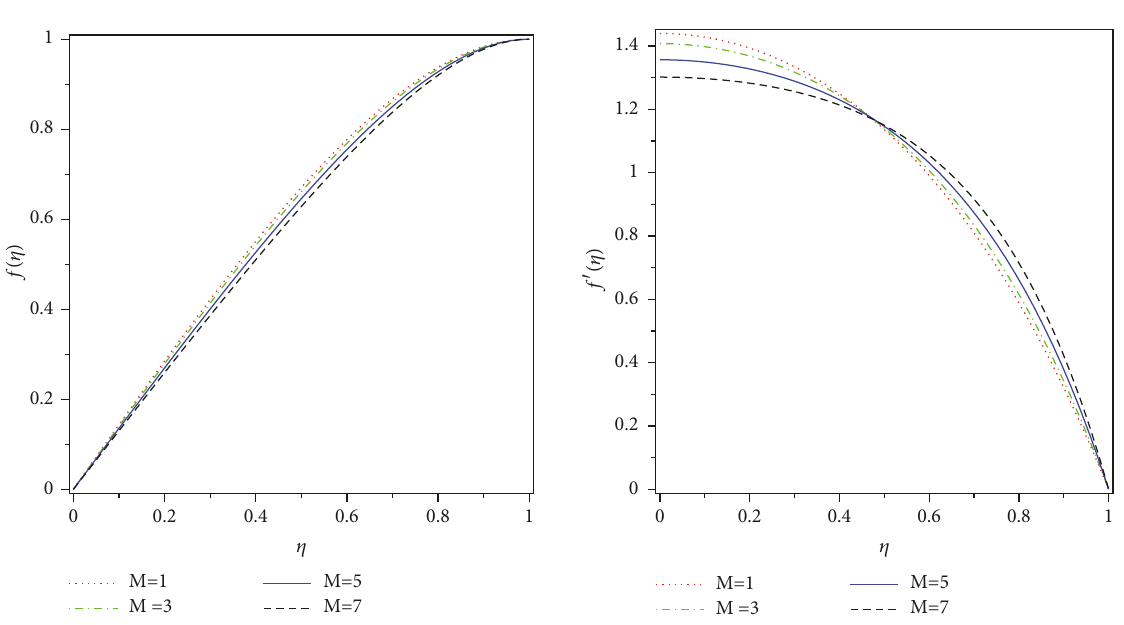
Figure 3: 𝑓(𝜂) and 𝑓 󸀠 (𝜂) for the values 𝑀 when 𝑆 = 3 , 𝛾 = 0.3 .